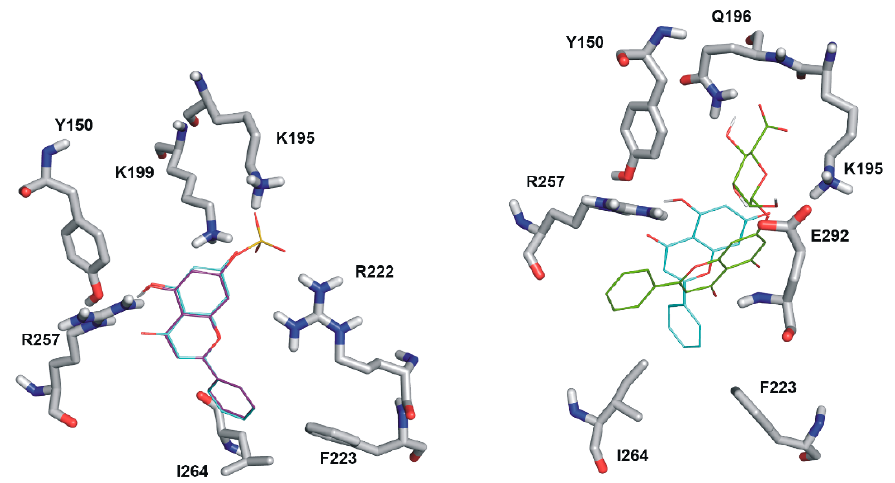
Figure 7. Left: Chrysin (cyan spheres) occupies Sudlow’s Site I in HSA (represented with grey cartoon). Right: Rank1 binding positions of chrysin (cyan lines) and warfarin (orange lines; reference structure) in the HSA molecule.